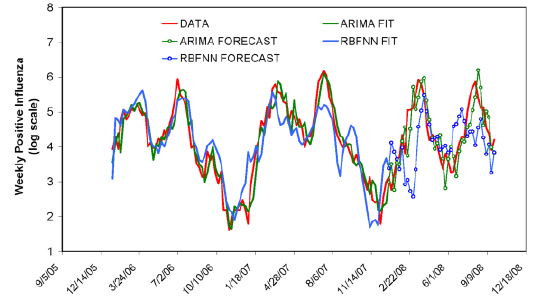
Figure 3. Modelled influenza cases in Hong Kong using ARIMA and radial basis function neural